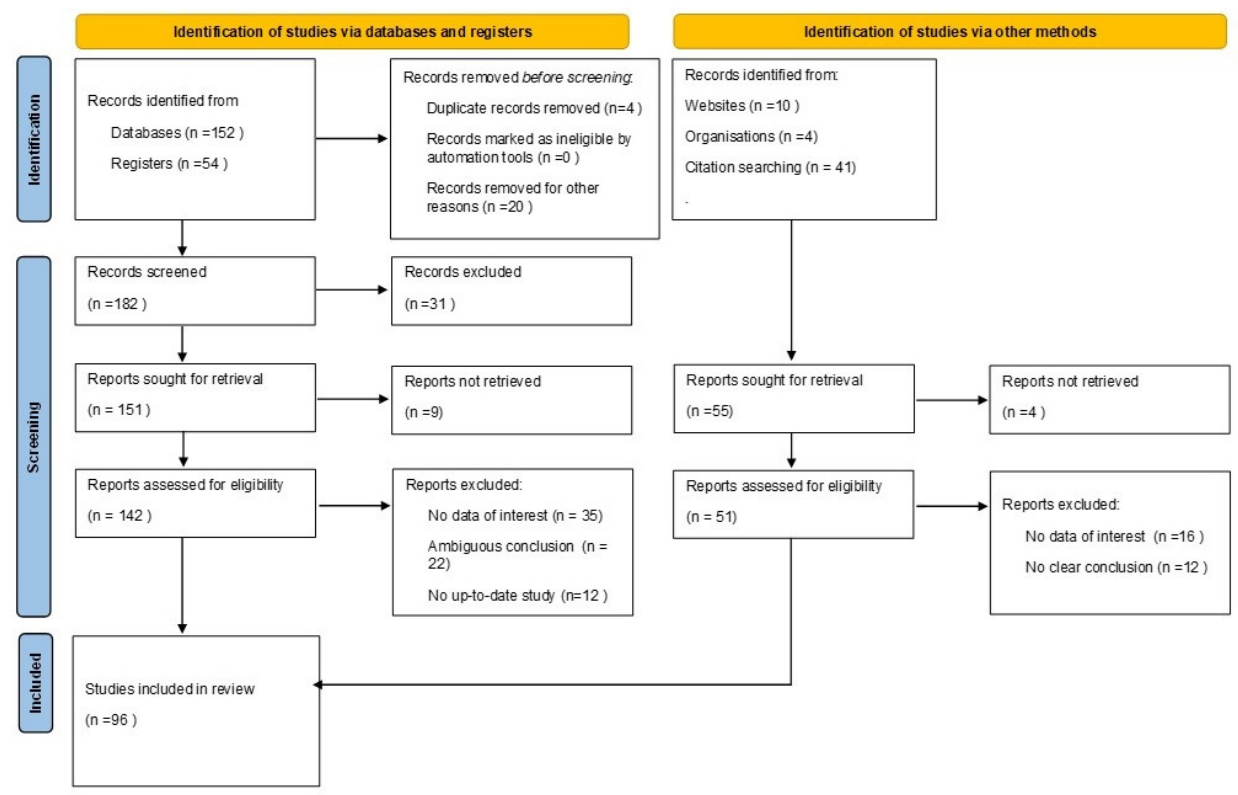
Figure 1. Schematic view of the methodology process.